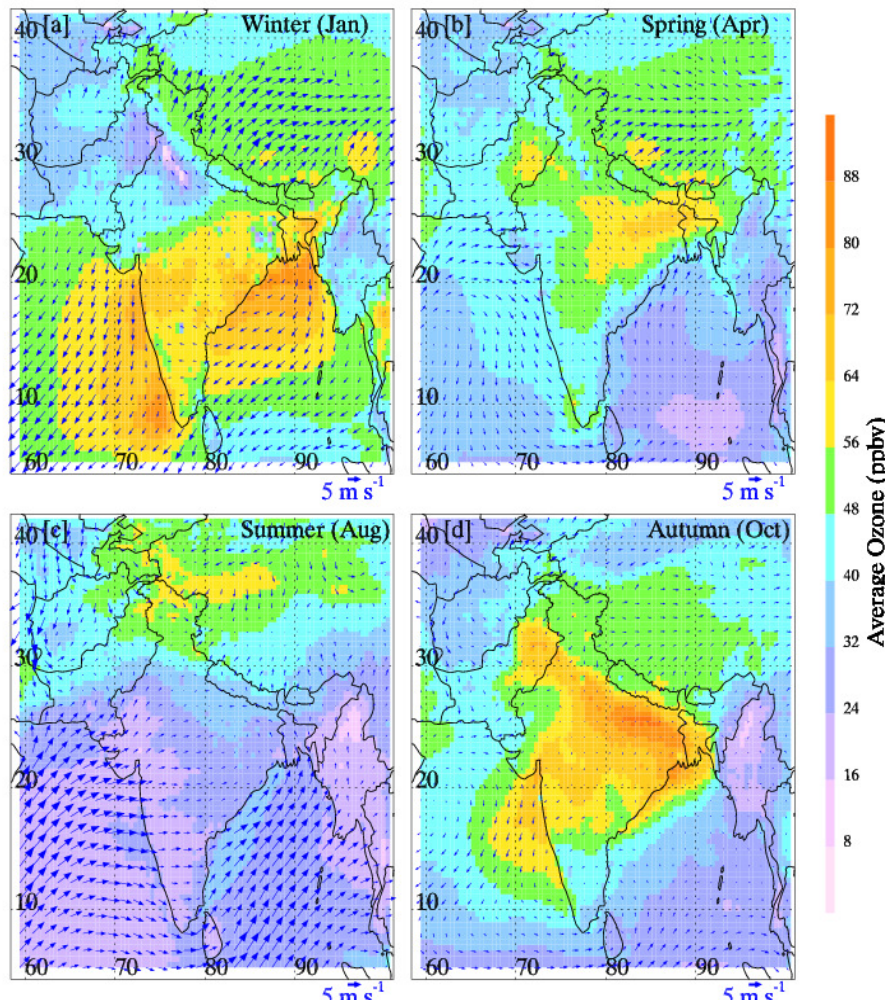
Fig. 17. Spatial distribution of WRF-Chem simulated surface ozone during January, April, August and October of the year 2008. Monthly mean 10 m wind vectors are also shown.